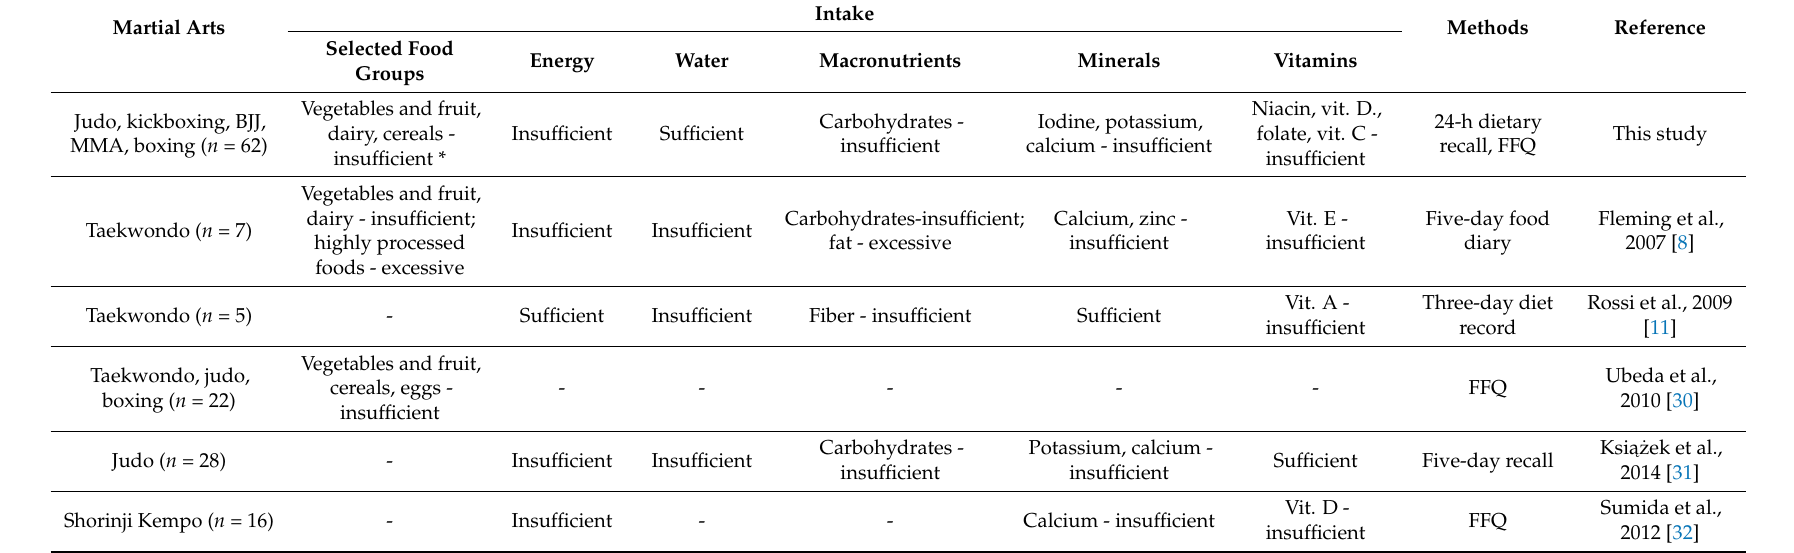
Table 4. Dietary Inadequacies among Professional Combat Male